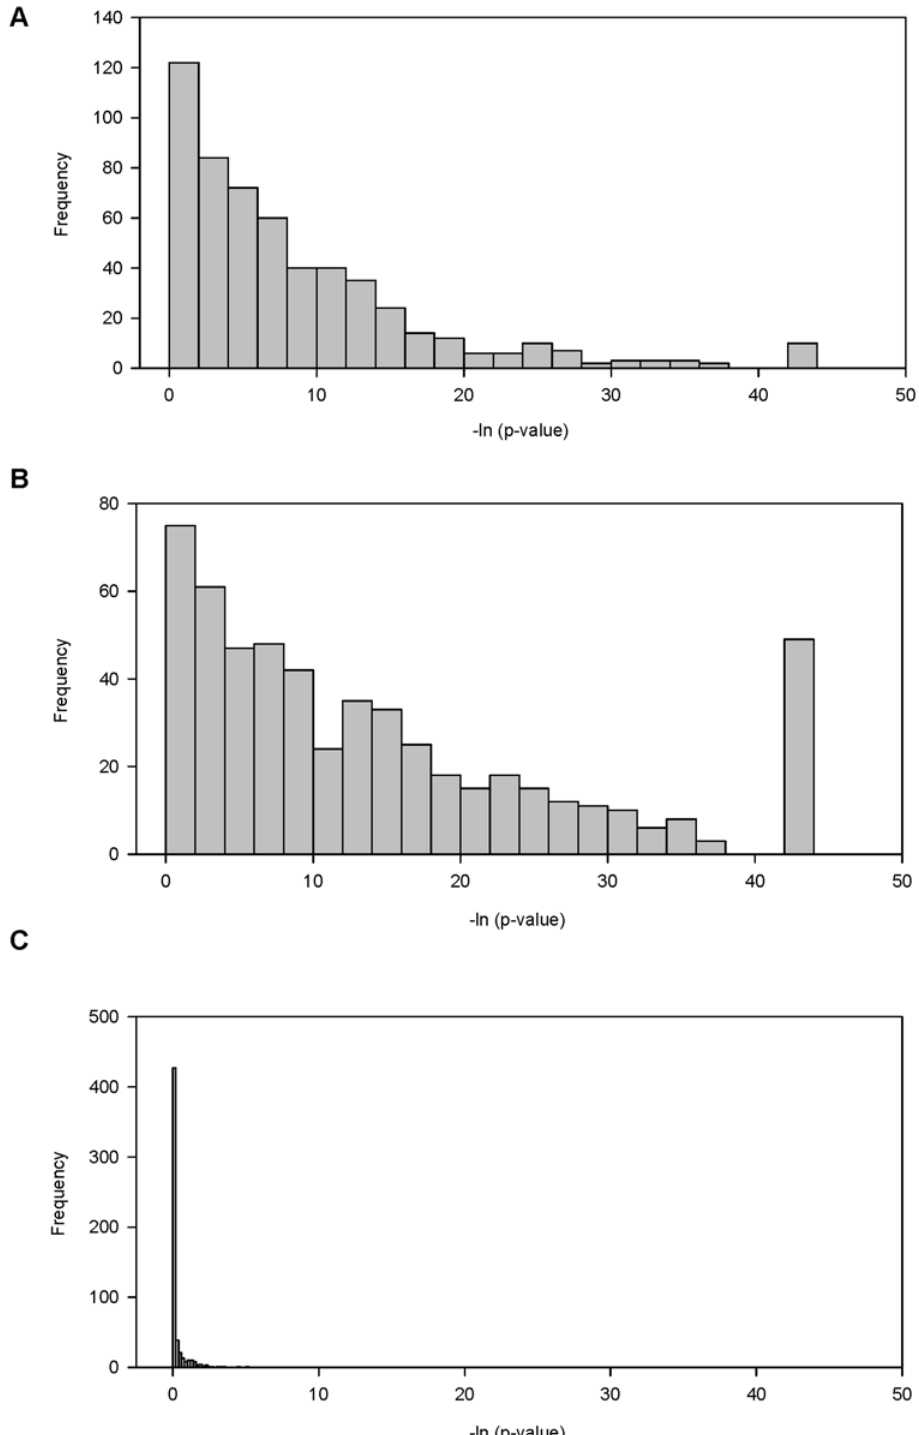
Fig 7. MicroRNAs predicted from sets of genes downregulated on PAA were significant different from genes unregulated on PAA. MicroRNA targets from genes sets that were, downregulated (subset of genes FC < -2), highly downregulated (FC < -10), or upregulated (FC > 2) were compared to predicted miRNA targets in the set of genes that was unregulated (FC < 1.2) utilizing Diana-mirExtra to identify miRNA that were statistically significant (p < 0.5) between the sets. The histograms show the number of